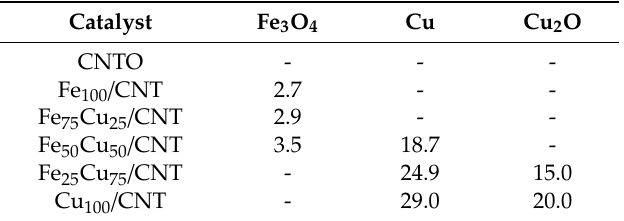
Figure 1. X-ray diffraction patterns of the catalysts. A: graphite; B: Fe 3 O 4 ; C: Cu 2 O; D: Cu. Table 1. Crystallite size (nm) of phases detected in oxidized carbon nanotubes (CNTO) and Fe 100 − x Cu x /CNT.